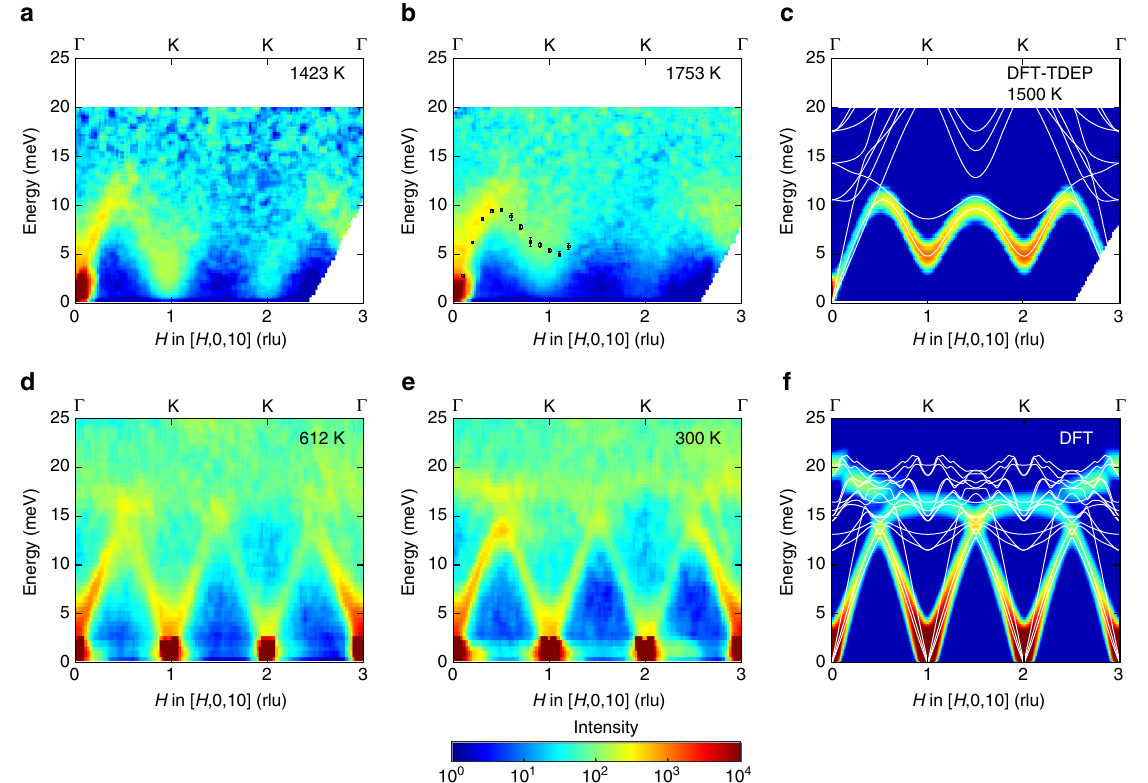
Fig. 2 Dynamics and condensation of the K 3 distortion across T FE . Phonon dispersions along [ H , 0,10] direction measured at T = a 1423, b 1753, d 612, and e 300 K are compared with intensity calculated from DFT model, χ ″ ( Q , E ), for c 1500 K and f 0 K DFT simulations (white lines in c , f are the calculated phonon dispersions along the [ H , 0, 10]). The (1, 0, 10) and (2, 0, 10) Bragg peaks at 612 and 300 K are due to the trimerization of the unit cell. In e , the phonon dispersion obtained by fi tting the scattering intensity is shown as black markers with error bars (one standard deviation on either side of the peak value). The INS signal was integrated over a range − 0.2 ≤ Q ⊥ ≤ 0.2 rlu for directions perpendicular to [ H , 0, 10]. The high symmetry points ( Γ and K) denoting the path above panels refer to the PE phase setting (K becomes Γ in the FE phase). The small difference between the measurements and simulations of phonon intensity near (2, 0, 10) is due to slightly different theoretical atomic coordinates (and consequently structure factor), and possible effects of sample rotation in the beam. The data in a , b and d , e were measured on HYSPEC (phonon annihilation) and ARCS (phonon